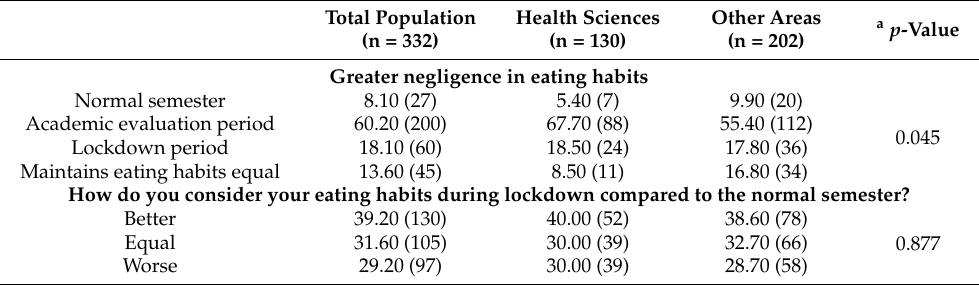
Table 6. Comparison of the self-perceived quality of eating habits between the normal semester and the period of lockdown due to COVID-19, according to the area of